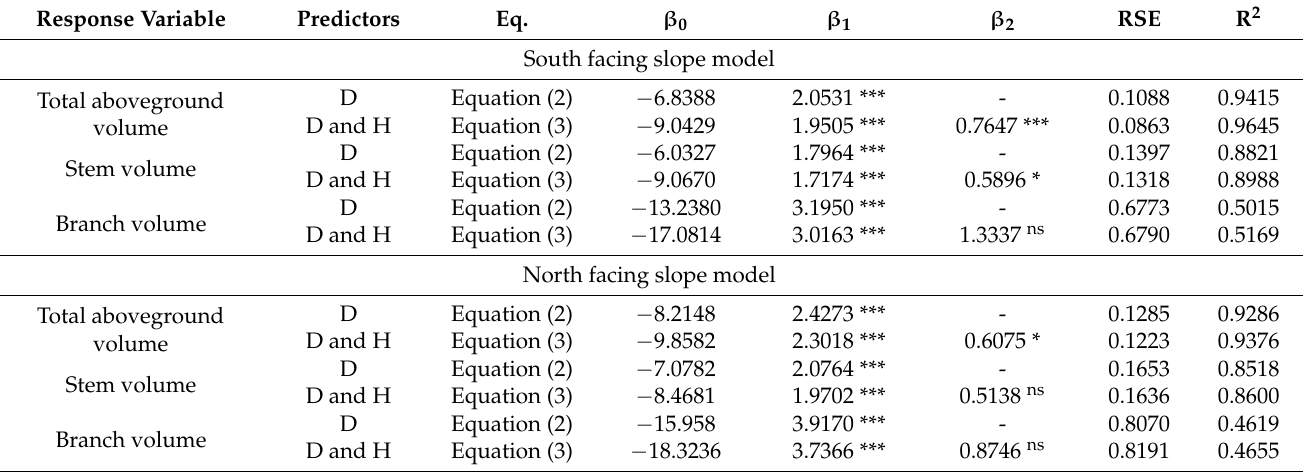
Table 3. The parameter estimates of Equations (2) and (3), for different response variables and datasets.